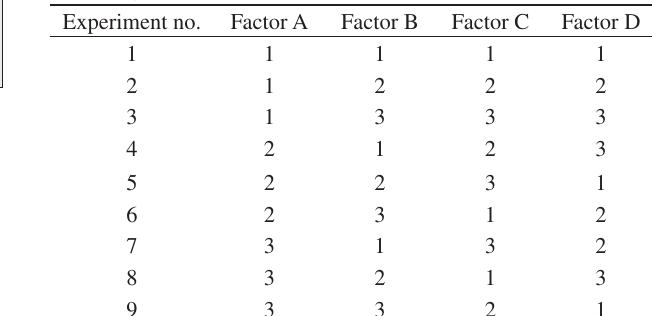
Table 2. L (3 4 ) Standard orthogonal 9